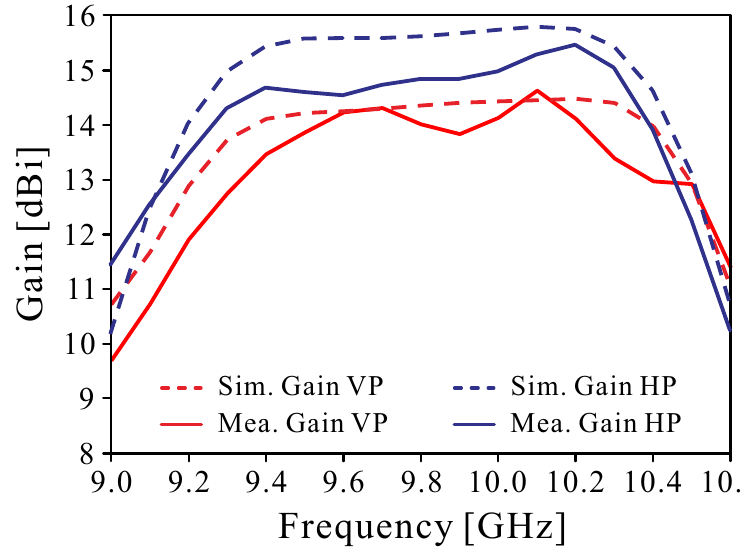
Figure 12. The measured realized gain of the dual-polarized antenna